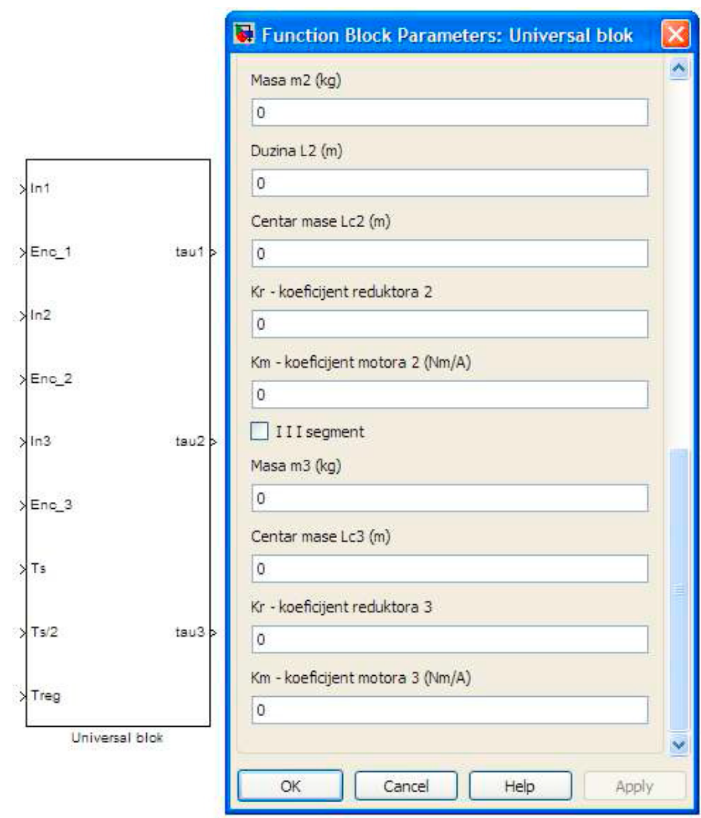
Figure 10. Universal control block and input mask [14].